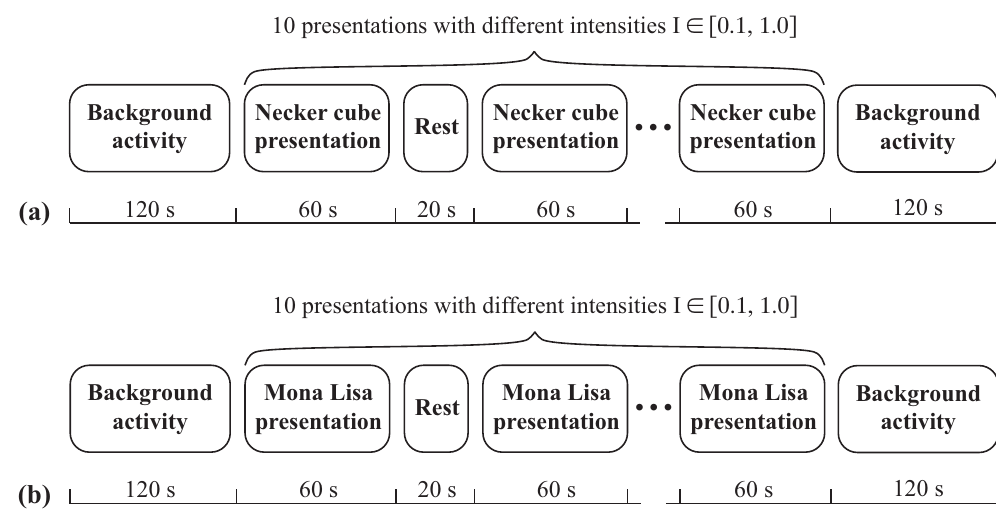
Figure 1. ( A ) Necker cube with intensity variant; ( B ) Mona Lisa portrait: Painting by Leonardo da Vinci with intensity variant; ( C ) Map of 31 EEG channels which were used in the experiment.